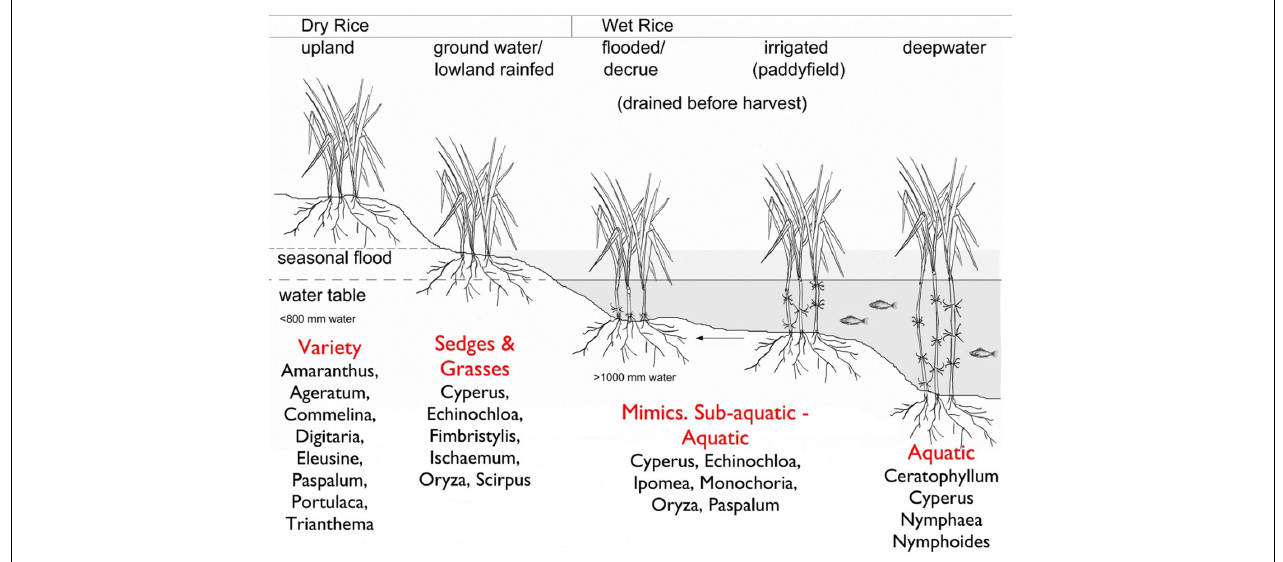
FIGURE 2 | From Kingwell-Banham (2019, Figure 3) “rice cultivation systems classified according to elevation and water availability, with example weed profiles (as per Fuller et al., 2010).” This shows the wide range of ecological settings for rice, and the diversity of weed ecologies that can cohabit them. This Figure has